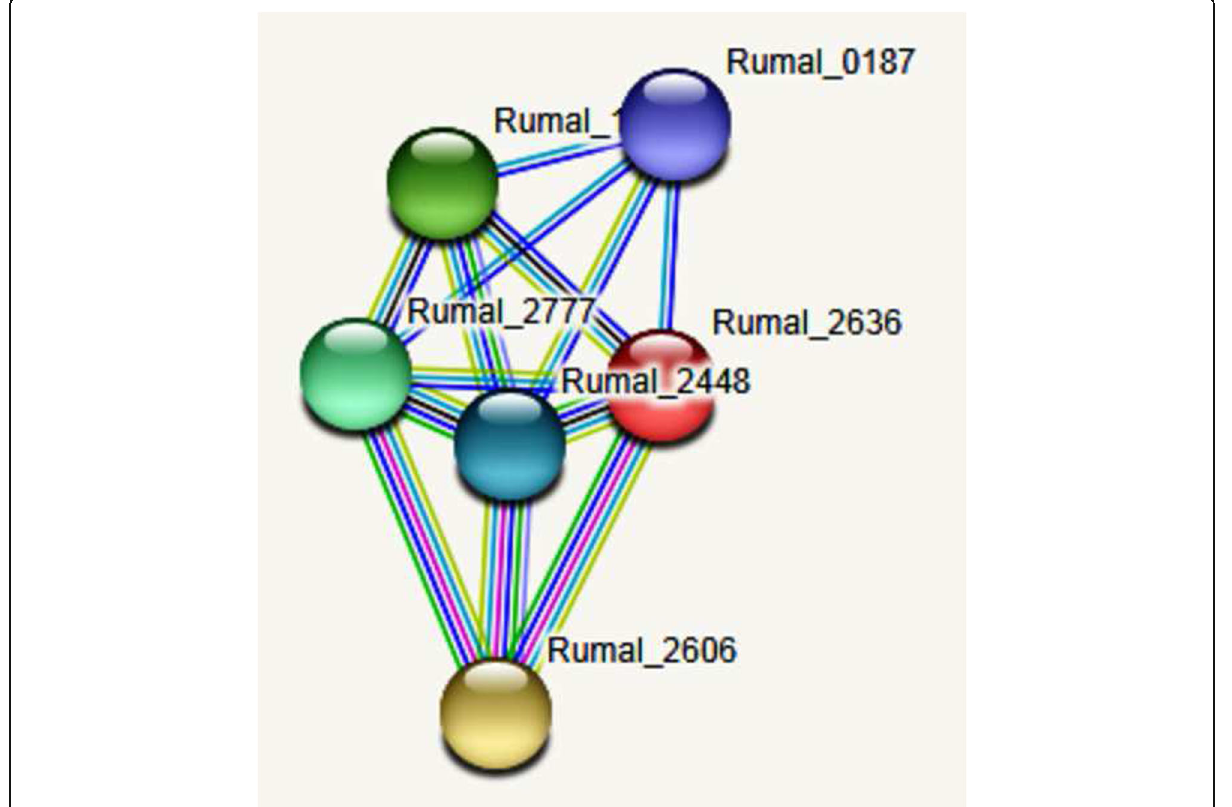
Fig. 6 Protein – protein interaction map for the cellulase of Ruminococcus